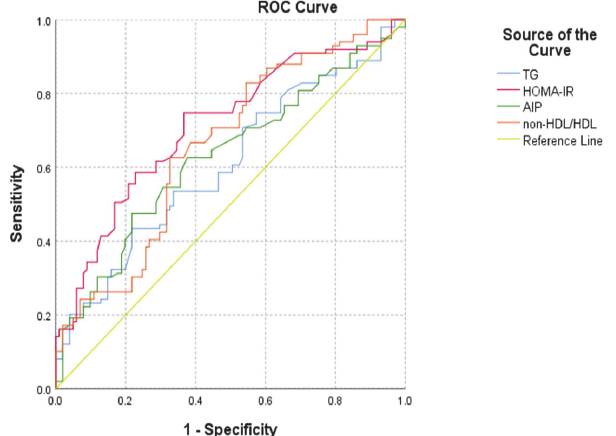
Figure 2. ROC curve for the biomarkers that were independently associated with MAFLD. AIP: atherogenic index of plasma; HDL: high ‐ density lipoprotein; HOMA ‐ IR: Homeostatic Model As ‐ sessment for Insulin Resistance. Table 5. AUROC and cut ‐ off values of the biomarkers that were found to be independent predictors of MAFLD in patients with T2DM.